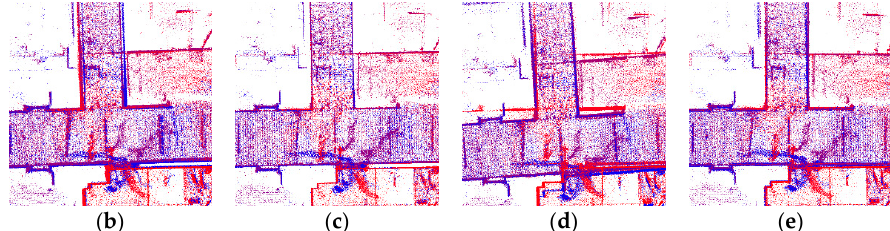
Figure 9. Comparison between the point clouds before and after optimization in dataset 1. ( a ) The top view of the point cloud after optimization; ( b ) enlarged view of the raw output point cloud of Cartographer; ( c ) enlarged view of the optimized point cloud of Cartographer; ( d ) enlarged view of the raw output point cloud of lidar odometry and mapping (LOAM); ( e ) enlarged view of the optimized point cloud of LOAM.